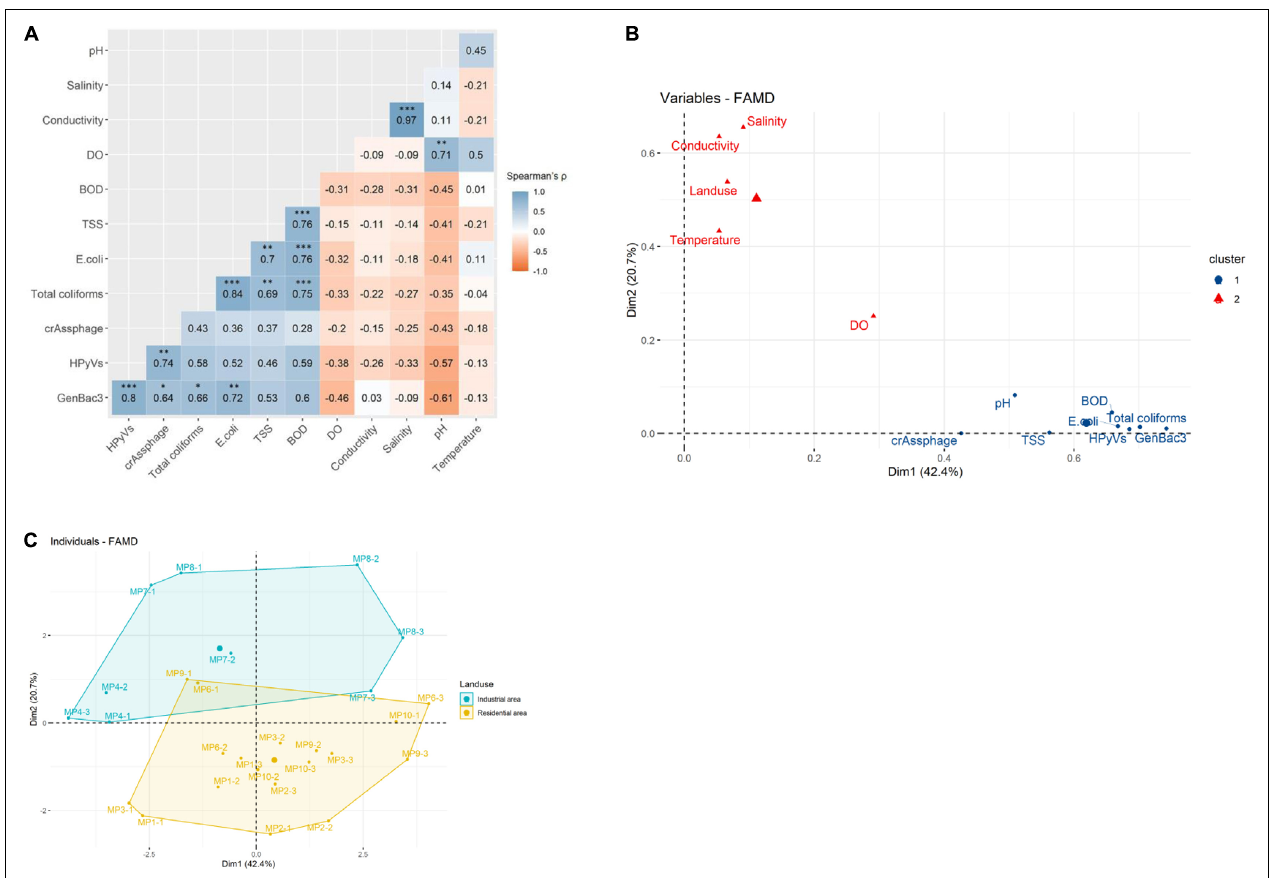
FIGURE 3 | Multivariate analysis for quantitative correlation using Spearman’s rho on U -score rank with ∗ , ∗∗ , and ∗∗∗ indicating Holm’s adjusted P -value < 0.05, 0.01, and 0.001, respectively (A) , clustered principal component analysis (PCA) using factor analysis of mixed data (FAMD) for water quality parameters (B) , and clustered PCA using FAMD for water samples (C)